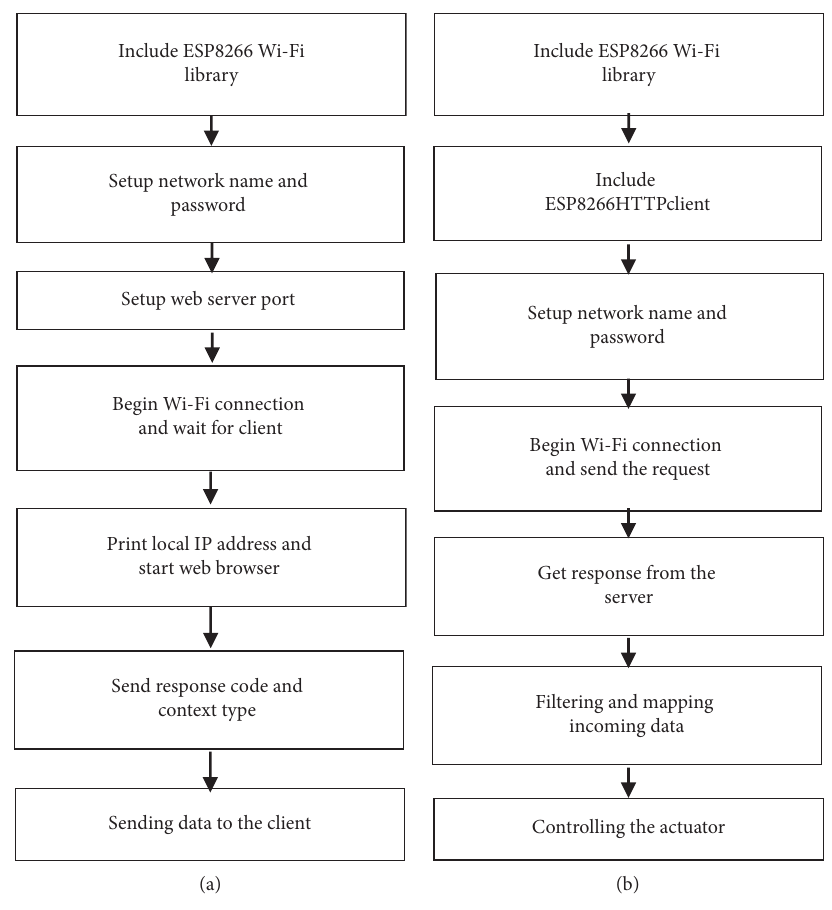
Figure 3: The operational flow. (a) Transmitter node (server). (b) Receiver node